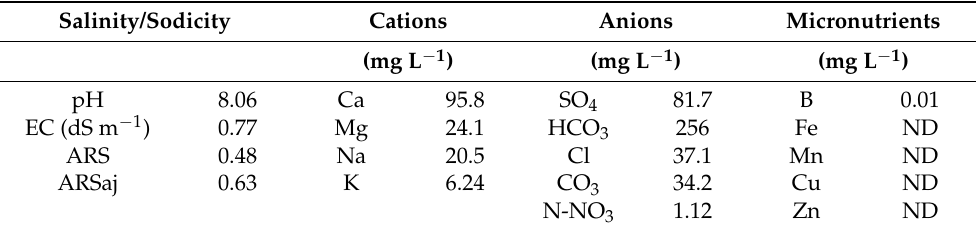
Table 2. General characteristics of salinity/sodicity, cations, anions, and special determinations of irrigation